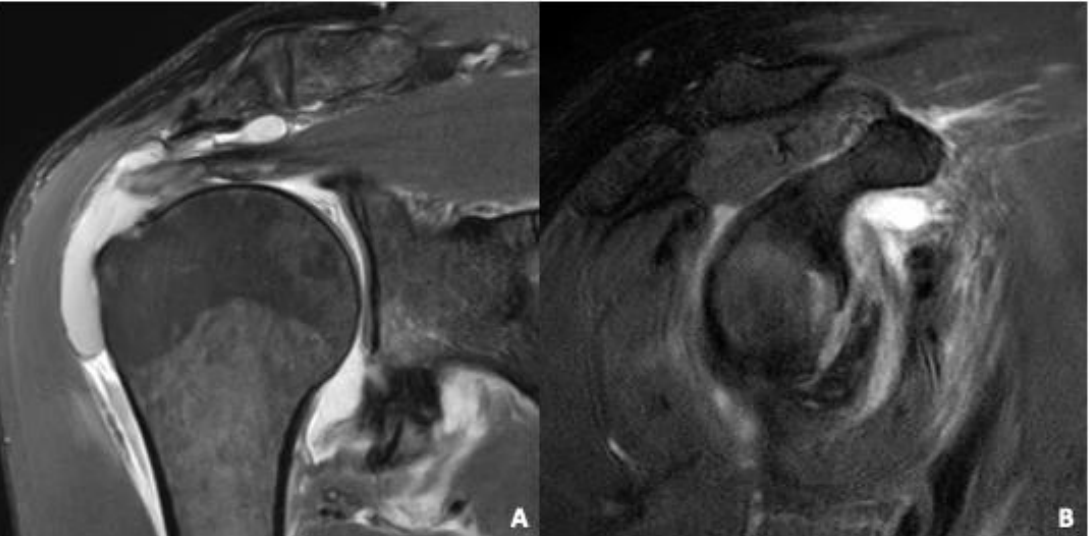
Figure 4. Concomitant injuries after acute anterior shoulder dislocation. ( A ) Coronal IM-weighted TSE sequence with spectral fat saturation. Complete tear of the proximal SSP tendon. Note the markedly increased joint effusion which fills the joint capsule. ( B ) Sagittal IM-weighted TSE sequence with spectral fat saturation. Bony Bankart Lesion with avulsion fracture of the anterior glenoid.